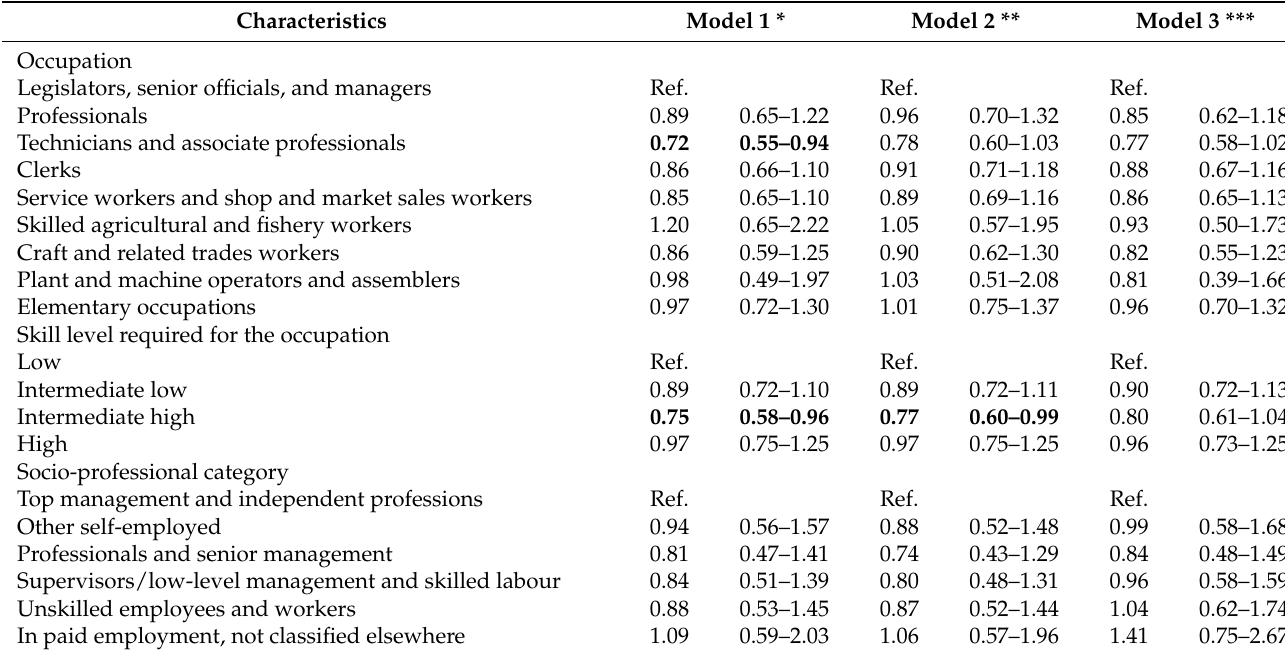
Table 4. Hazard ratios and associated 95%-confidence interval for lung cancer relative survival by work-related variables among females aged 18–85 in French-speaking Switzerland